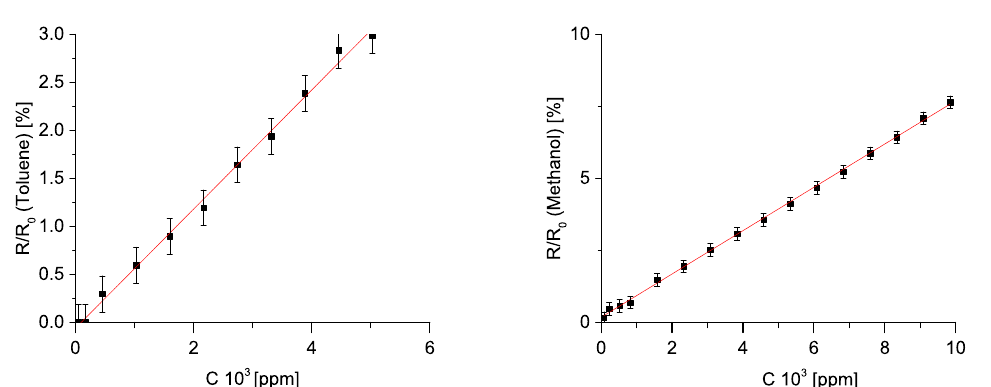
Figure 7. Dependence of electrical resistance of an oxidized sample on organic solvent vapour concentration (in ppm). From left to right and from top to bottom the plots represent the response to acetone, isopropanol, chlorobenzene, ethanol, toluene, and methanol, respectively. Error bars show five standard deviations. For details see Section 3.